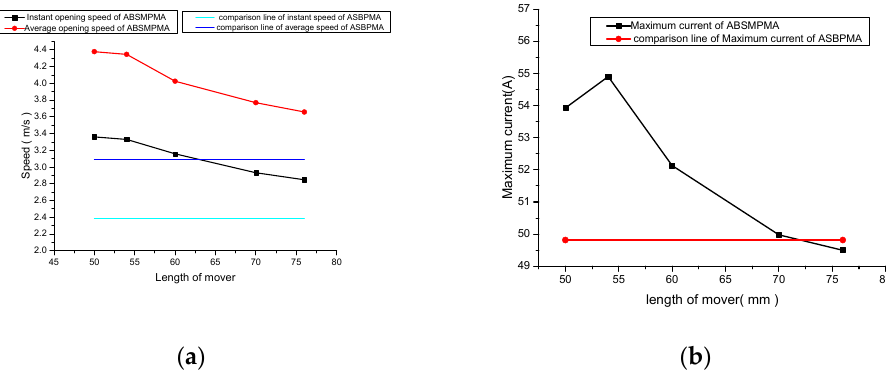
Figure 7. The opening characteristics are shown. ( a ) The characteristic of length of mover vs. opening speed. ( b ) The characteristic of length of mover vs. maximum opening current.